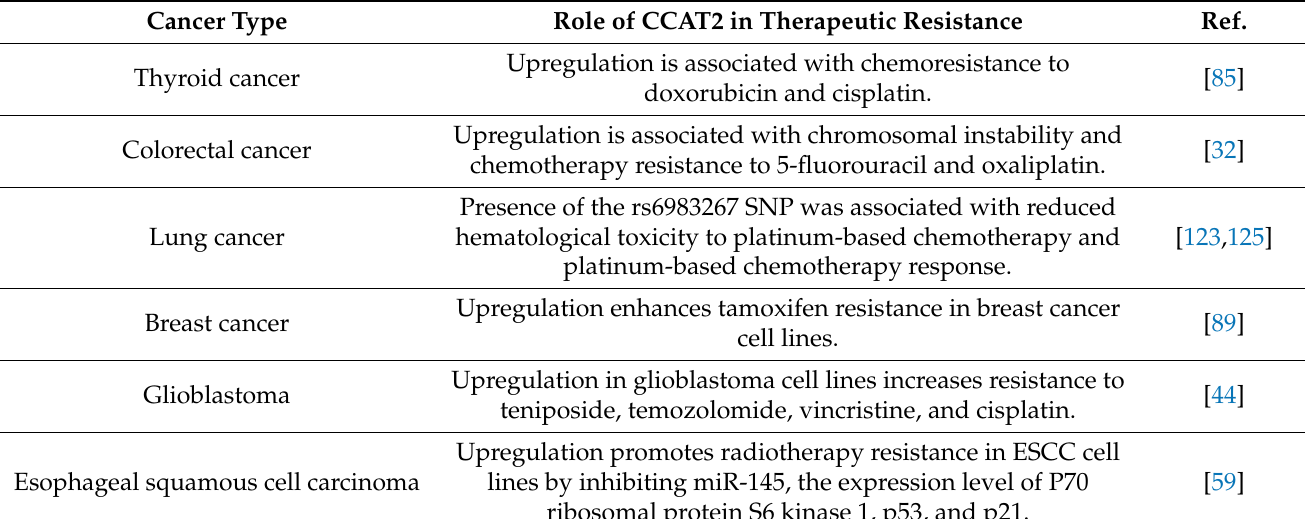
Table 2. CCAT2 regulatory roles on therapeutic resistance in human